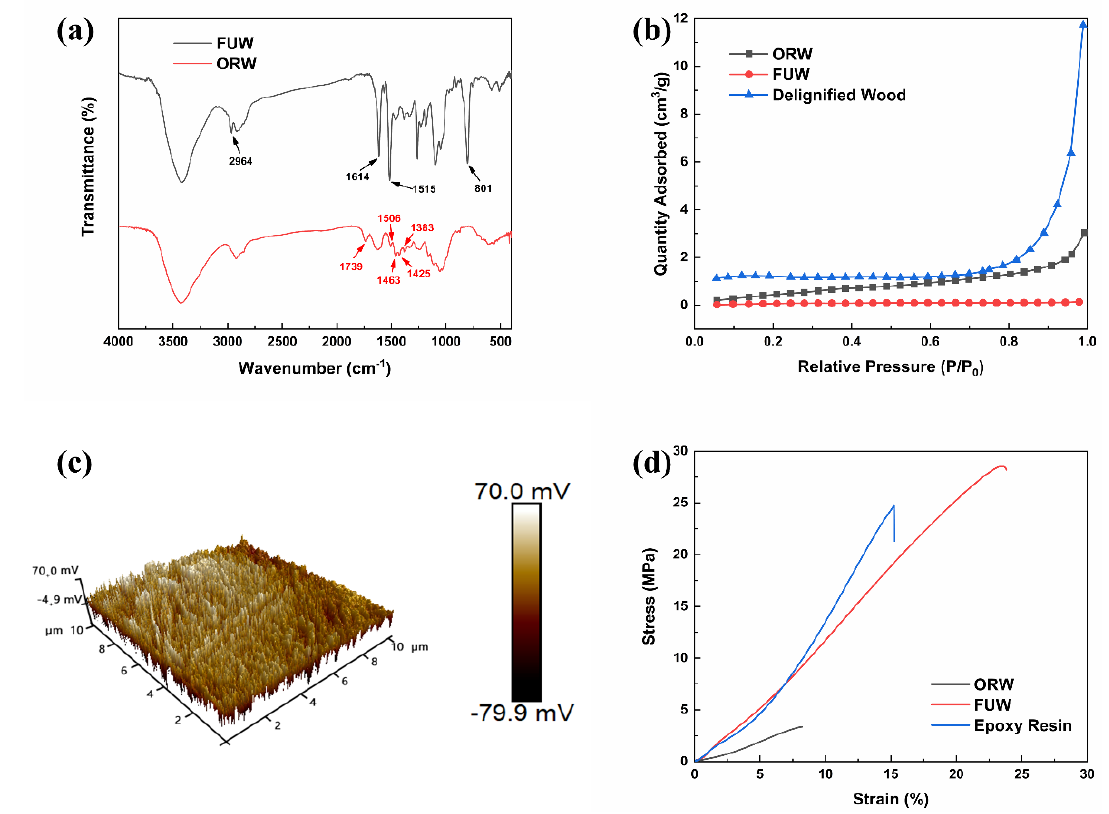
Figure 3. The FTIR spectra of ORW and FUW ( a ); N 2 adsorption − desorption isotherms of ORW, FUW and delignified wood ( b ); AFM image of FUW ( c ); stress − strain curves of ORW, FUW and tris(oxiran − 2 − ylmethyl)amine/DDM epoxy resin ( d ).